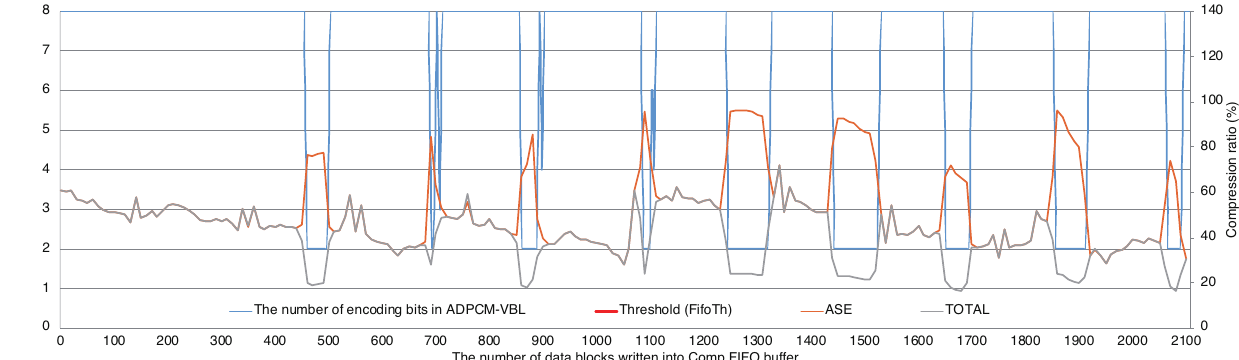
The original first frame of the evaluation video a)